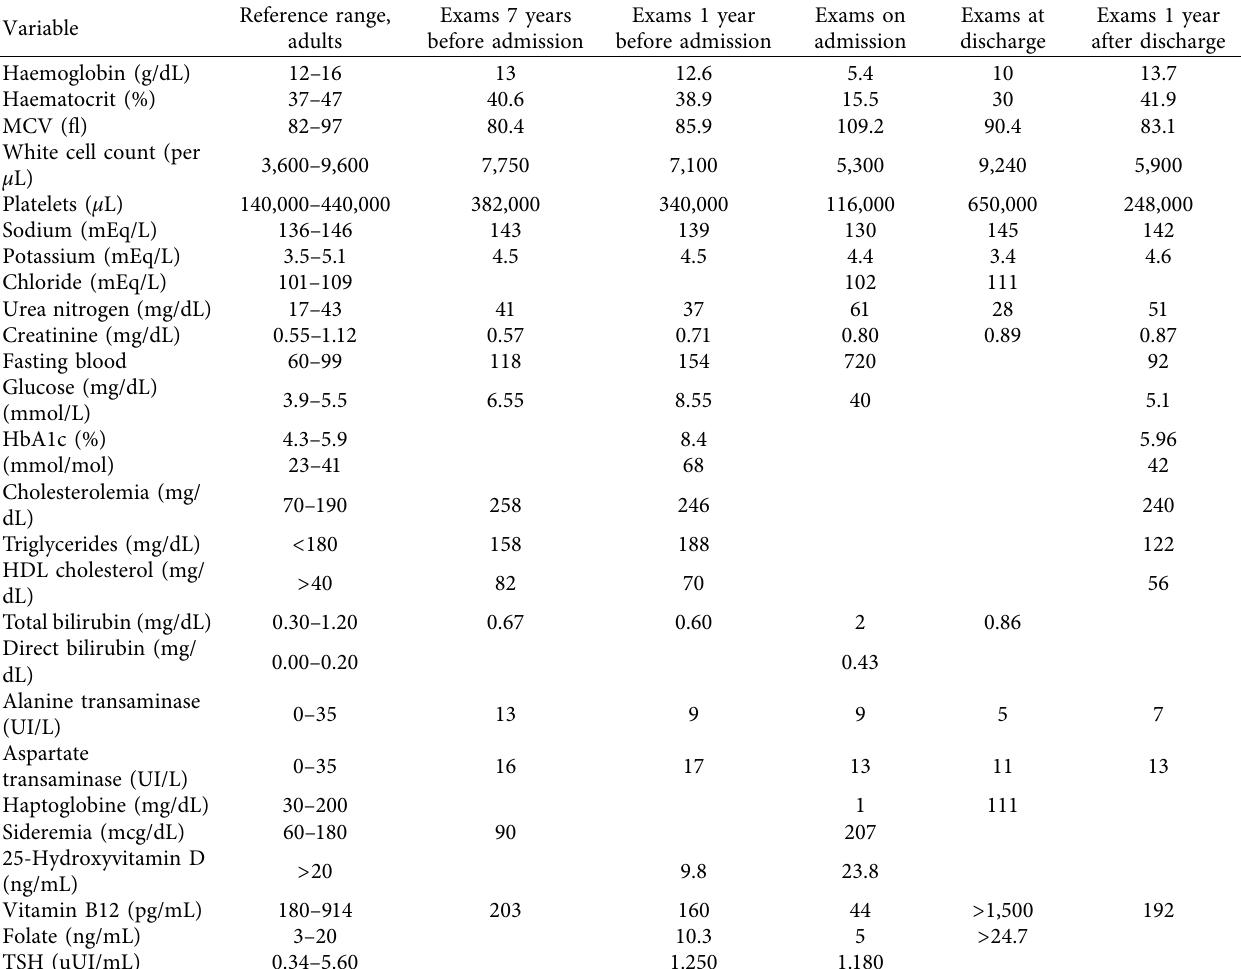
Table 1: Laboratory data.